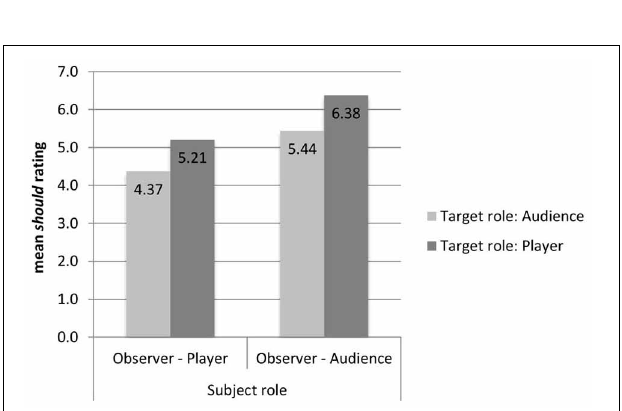
FIGURE 4 | Mean rating of “The player/audience member should press the button” (1 Strongly disagree to 9 Strongly agree).